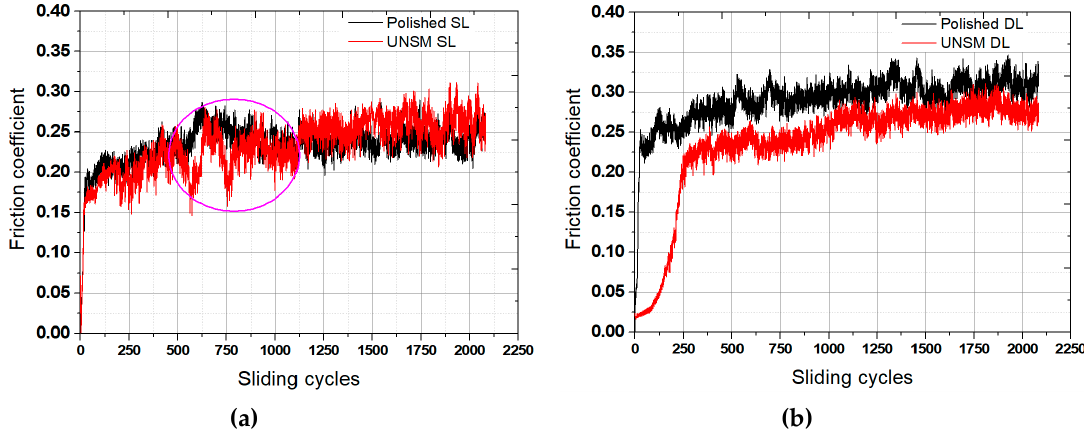
Figure 9. Friction coefficient results of the polished and UNSM-treated single ( a ) and double ( b ) layers.